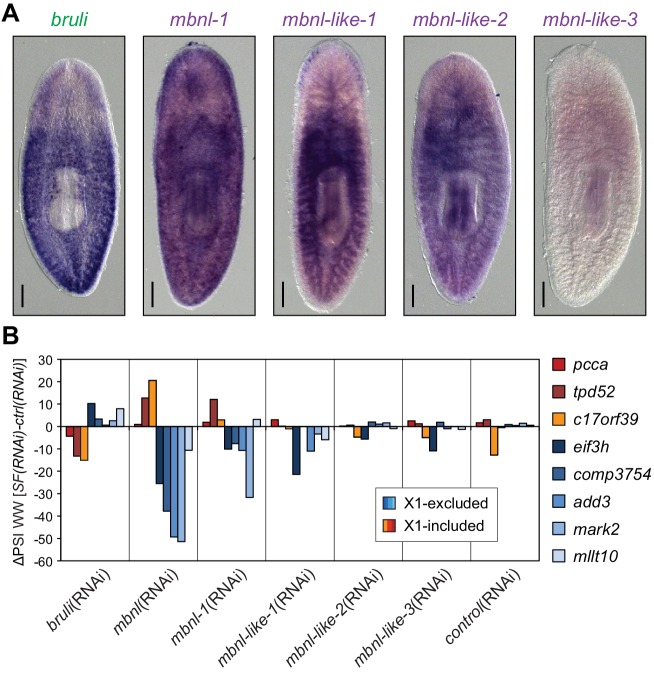
Combined mbnl knockdown has stronger effects than individual knockdown.(A) Whole worm in situ hybridization for bruli, mbnl-1 and mbnl-like1, 2 and 3. Scale bar is 0.5 mm. (B) ΔPSI in whole worm estimates by RT-PCR for two X1-inc exons (red), one X1-inc retained intron (c17orf39, orange) and five X1-exc exons (blue) 10 days after RNAi treatment with dsRNA coding for bruli, mix of dsRNAs against the four mbnl genes [mbnl(RNAi)], mbnl-1, mbnl-like-1, mbnl-like-2, and mbnl-like-3. Two independent controls samples were included; ΔPSI values are relative to the first control sample.